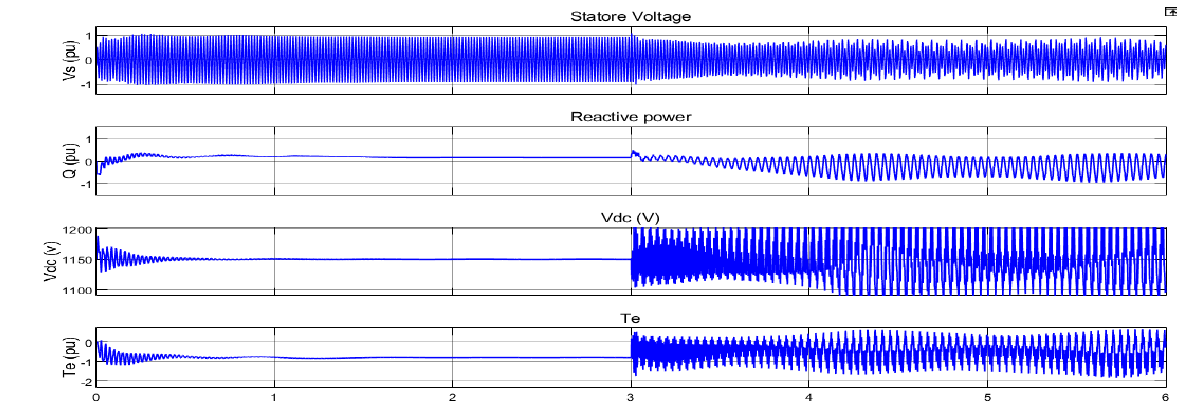
Figure 8. Capacitor voltage, reactive power stator voltage, and electrical torque in k = 25% to k= 75%&v = 7 m/s without damping.